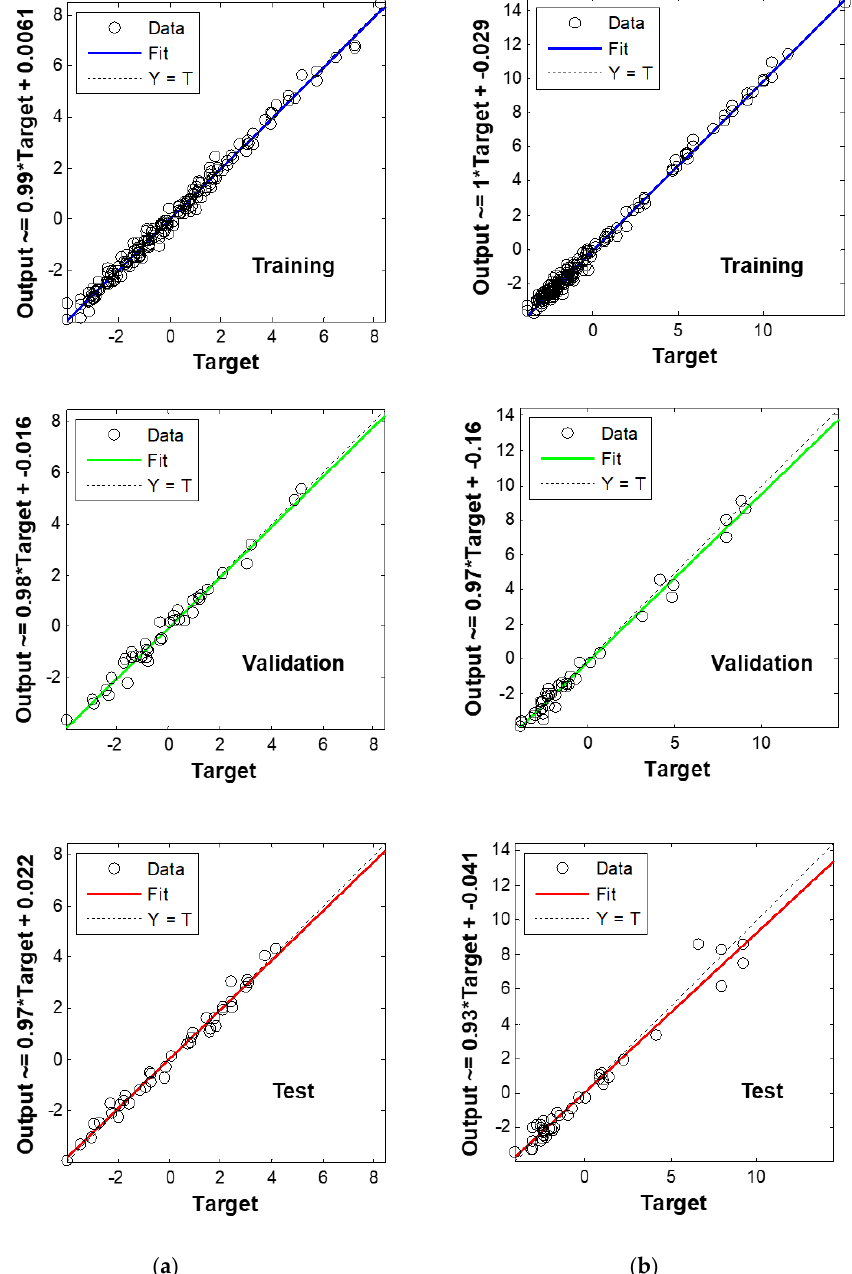
Figure 4. Partial least squares (PLS)-artificial neural network (ANN) regression curves of target value (X) versus output values (Y) of the ( a ) Perimysium area (%) and ( b ) intramuscular fat (g × 100 g − 1 DM) parameters obtained for training, validation, and test steps of the models.